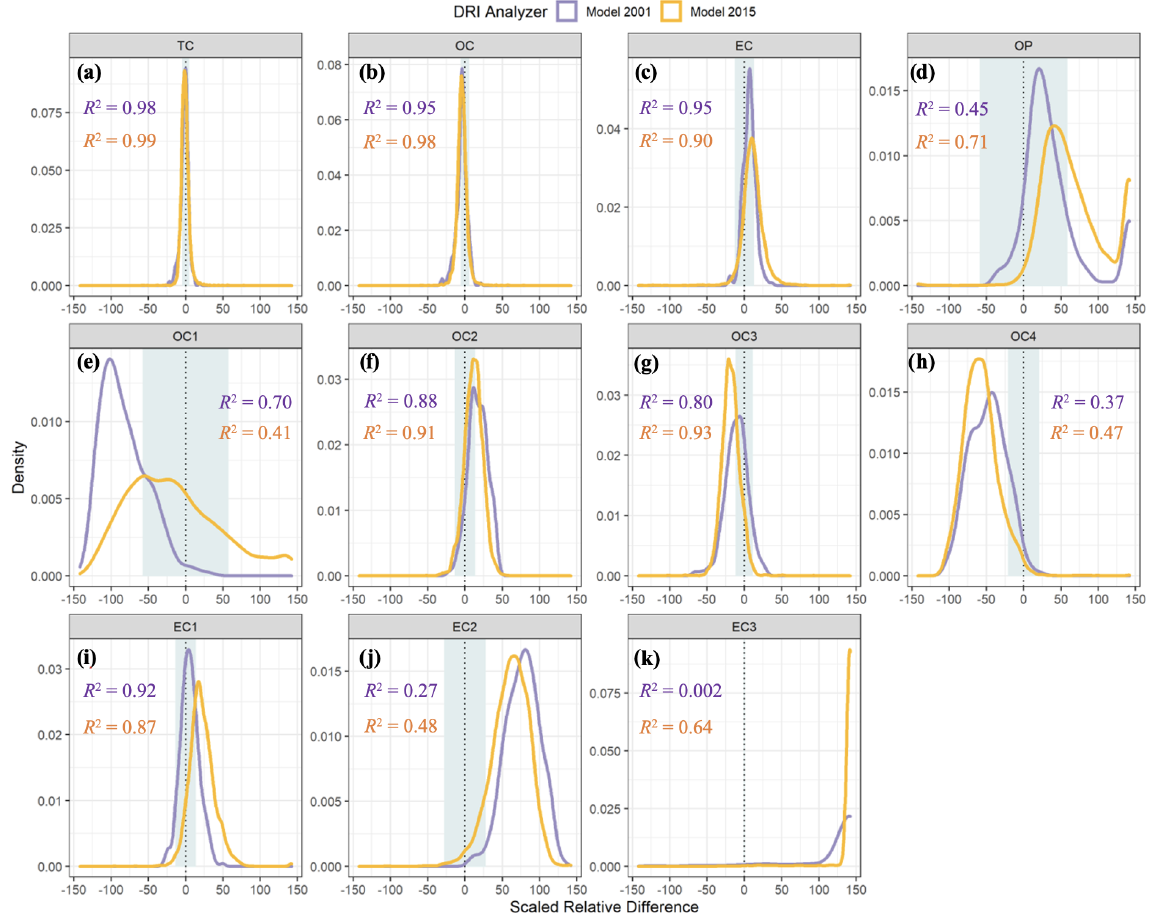
Figure 3. Probability density curves of scaled relative differences (Eq. 8, %) between the Sunset analyzer vs. two DRI analyzers for all carbon components (a–k) . Yellow lines (and text) denote the CSN 2017 samples ( n = 4073) analyzed by DRI model 2015 and Sunset, whereas the purple lines (and text) denote the archived CSN 2007 samples ( n = 303) analyzed by DRI model 2001 and Sunset. R 2 values are derived from linear regression of each dataset. The gray shaded area indicates the inter-model uncertainty (Eq. 6a, %) for each carbon component except for EC3 (Table